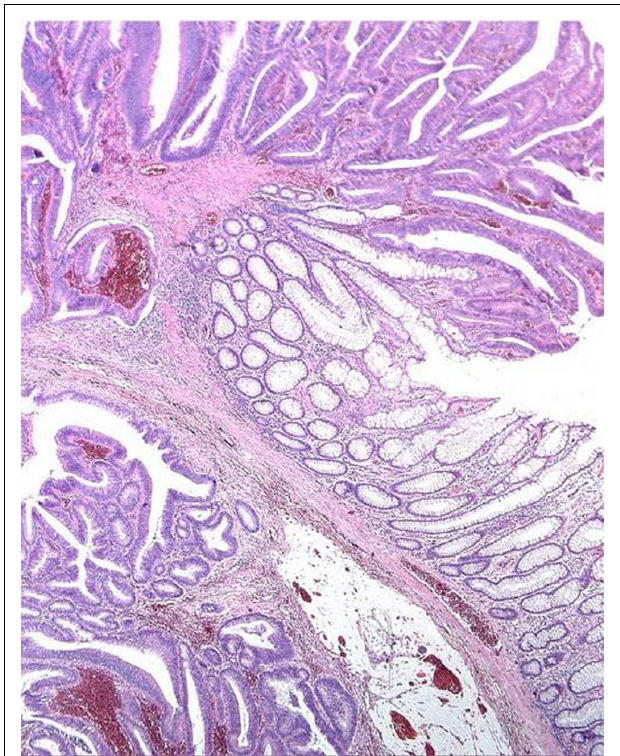
FIGURE 2 | Displacement of glands beyond the muscularis mucosae (“Pseudo-invasion”). The displaced glands are surrounded by lamina propria and close to hemosiderin